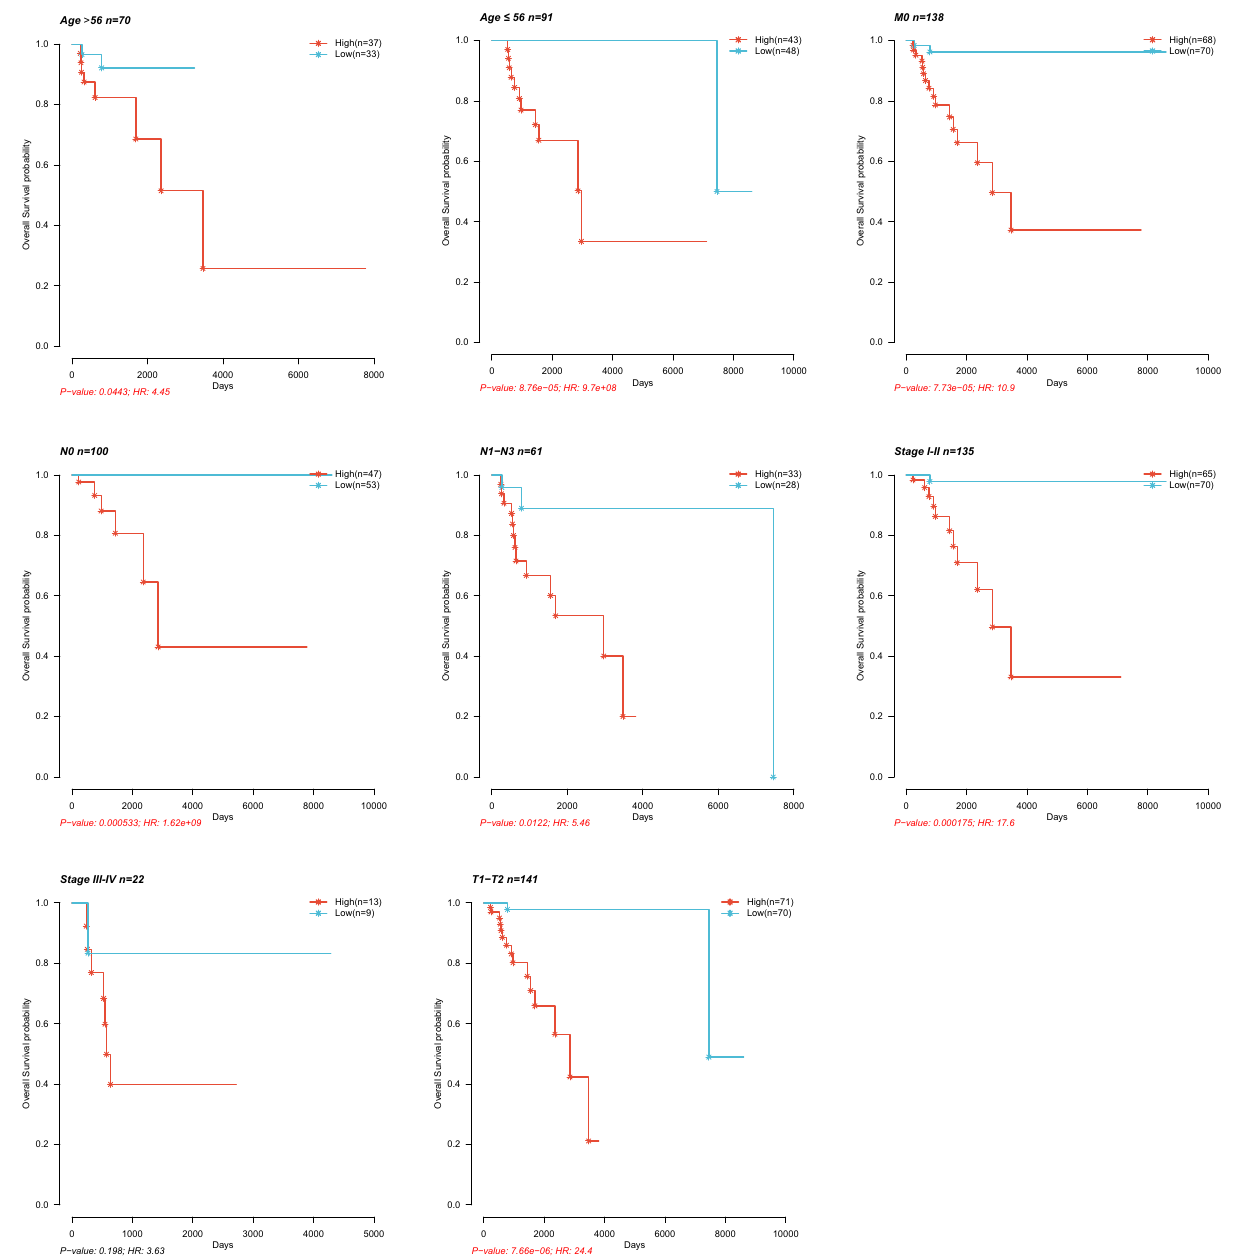
Figure A3: Kaplan – Meier survival analysis between high - risk and low - risk groups in patients in di ff erent